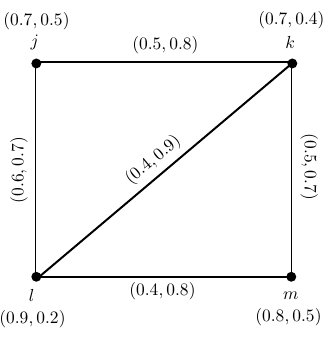
Figure 10. Union of two